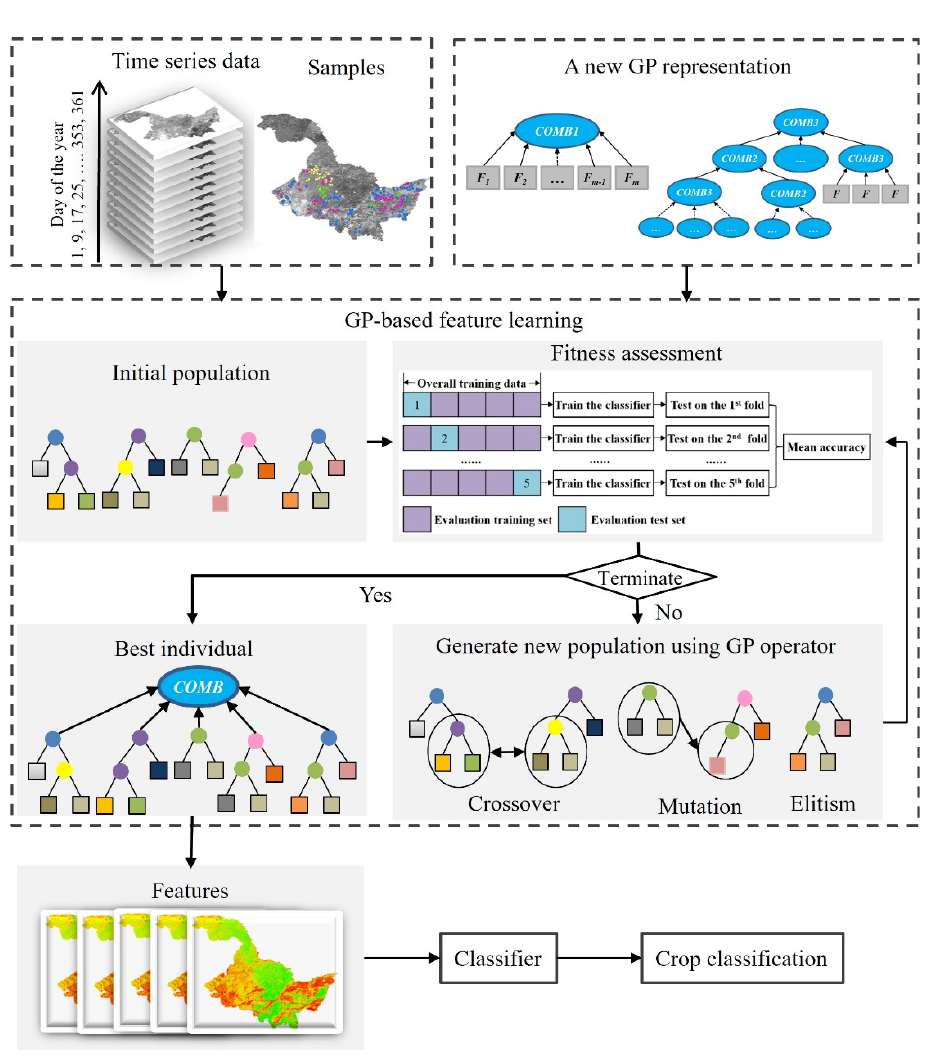
Figure 2. The workflow of GP for feature learning in crop classification.